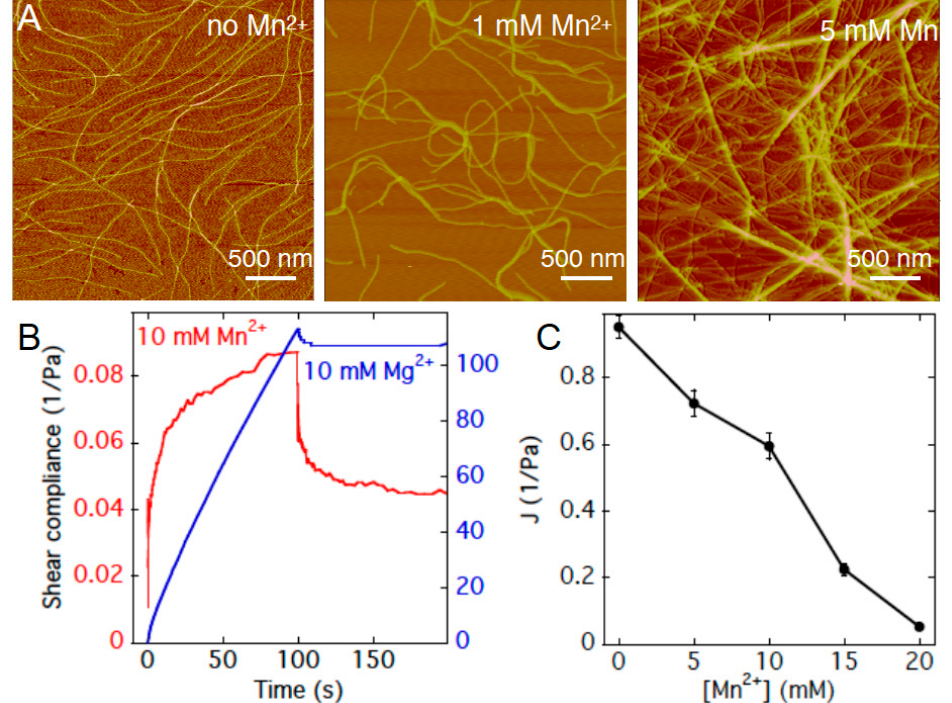
Figure 2. Gelation of Pf1 virus by Mn 2+ . ( A ). Atomic force micrograph of Pf1 virus in suspensions of variable amounts of Mn 2+ . ( B ). Creep and recovery of Pf1 suspensions with 10 mM Mg 2+ or Mn 2+ after imposition of a constant shear stress. ( C ). Compliance at 10 s of Pf1 suspensions with various concentrations of Mn 2+ . Error bars denote standard errors of separate experiments imposing 0.04 to 0.2 Pa shear stress.